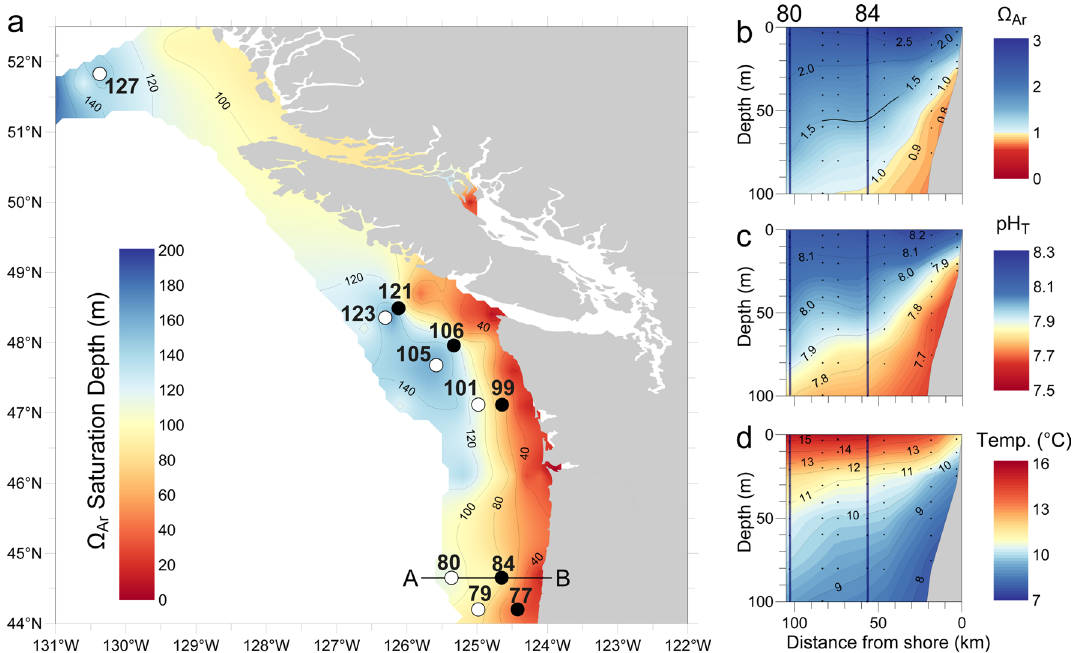
Figure 1. Aragonite saturation along the northern California Current Ecosystem. ( a ) Map representing the aragonite saturation horizon, defined as the depth at which Ω Ar = 1, between May 28th and June 7th of 2016. Waters with Ω Ar < 1 are considered undersaturated. Limacina helicina pteropods were sampled from 11 stations, indicated by open and closed symbols for offshore and nearshore stations, respectively. ( b–d ) Depth distributions of ( b ) Ω Ar , ( c ) pH T , and ( d ) temperature (°C), along the offshore-onshore gradient from locations A to B indicated on the map. Each dot in ( b – d ) indicates a sampling point, and stations 80 and 84 are indicated by vertical lines. Undersaturated conditions (Ω Ar < 1) come close to the surface in nearshore waters and deepen